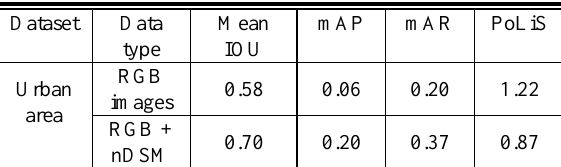
Table 3. Extraction results on the urban area of the Enschede dataset. the mAP, mAR and PoLiS are calculated on the polygons with 1 pixel tolerance for